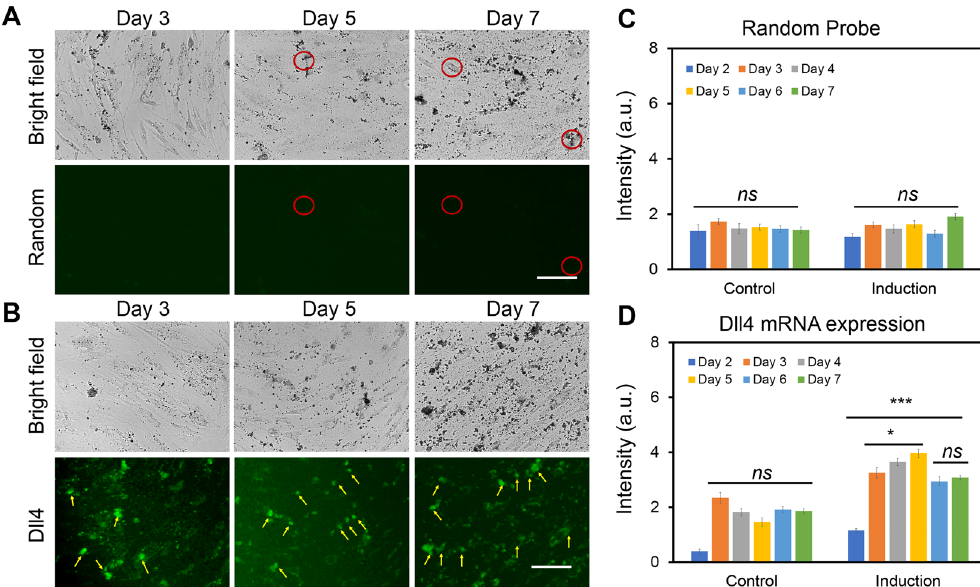
Figure 3. Negative control and Dll4 mRNA tracking of hMSCs during osteogenesis. Representative bright field and fluorescence images of hMSCs after 3 d, 5 d, and 7 d of osteogenic induction. ( A ) Green fluorescence indicates the signal of negative control of random probe. ( B ) Dll4 mRNA expression tracking of hMSCs during osteogenic induction after 3 d, 5 d, and 7 d of osteogenic induction. Green fluorescence indicates Dll4 mRNA expression. Yellow arrows indicate the differentiated cells expressing Dll4 mRNA. ( C ) Mean fluorescent intensity of random probe in hMSCs at different time points under control and induction group. ( D ) Mean fluorescent intensity of Dll4 mRNA expression in hMSCs at different time points under control and induction group. Control group: cells were cultured and maintained in basal medium. Induction group: Cells were cultured in basal medium and induced by osteogenic induction medium after 2 days of cell seeding. Images are representative of at least three independent experiments. Scale bar: 50 μm. Data represent over 100 cells in each group and are expressed as mean ± s.e.m. (n = 3). p -values were calculated using a two-sample t -test with respect to day 2. * p < 0.05; ** p < 0.01; *** p <